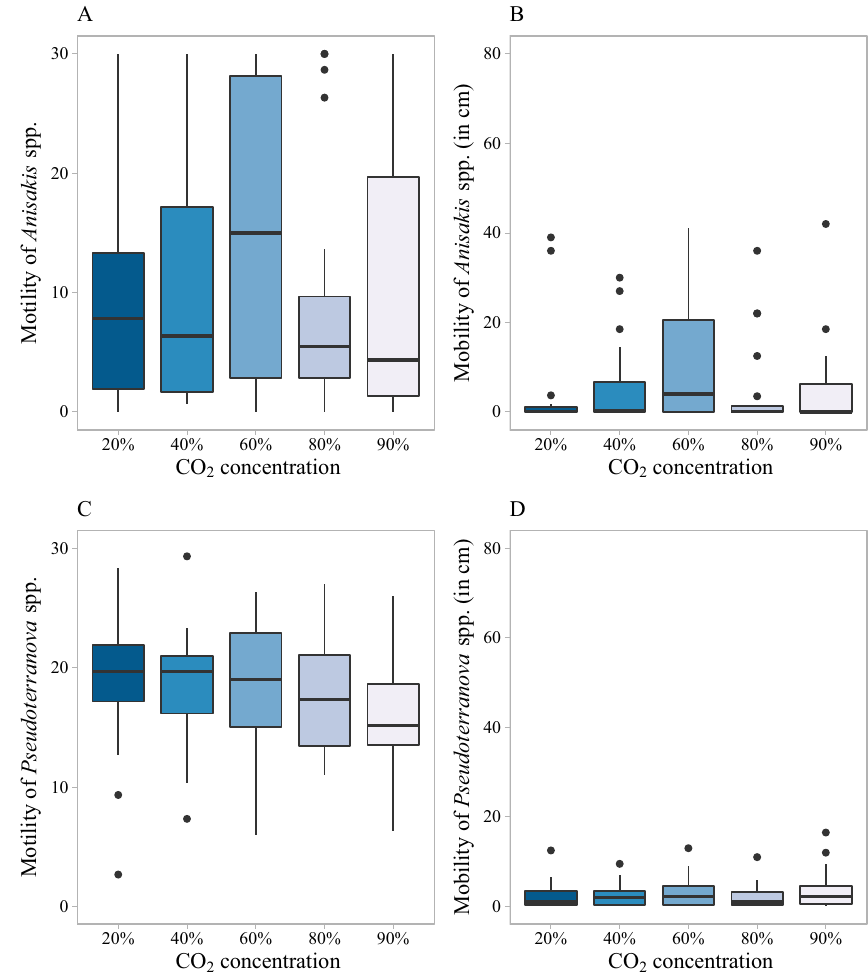
Figure 3. Effect of CO 2 on larval motility and mobility at 12 ℃ during the first 30 min. (A) Motility of Anisakis spp., (B) mobility of Anisakis spp., (C) motility of Pseudoterranova spp. and (D) mobility of Pseudoterranova spp. under different CO 2 conditions. The box consists of the upper quartile, median and lower quartile. The whiskers are drawn up to the highest or lowest observed point from the dataset that falls within 1.5 times the interquartile range. Observations beyond the end of the whiskers are plotted